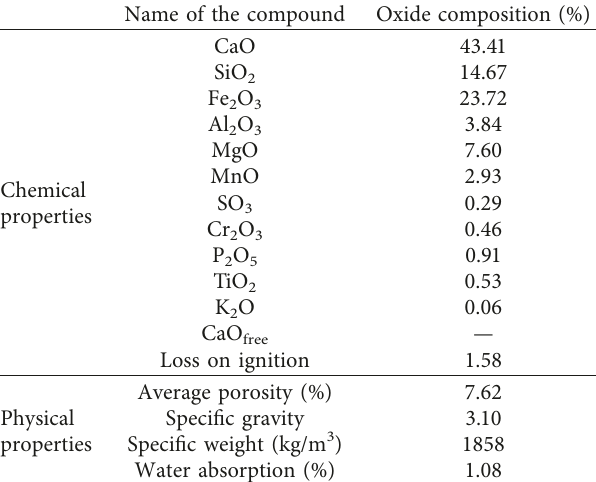
Table 2: Physical and chemical characteristics of